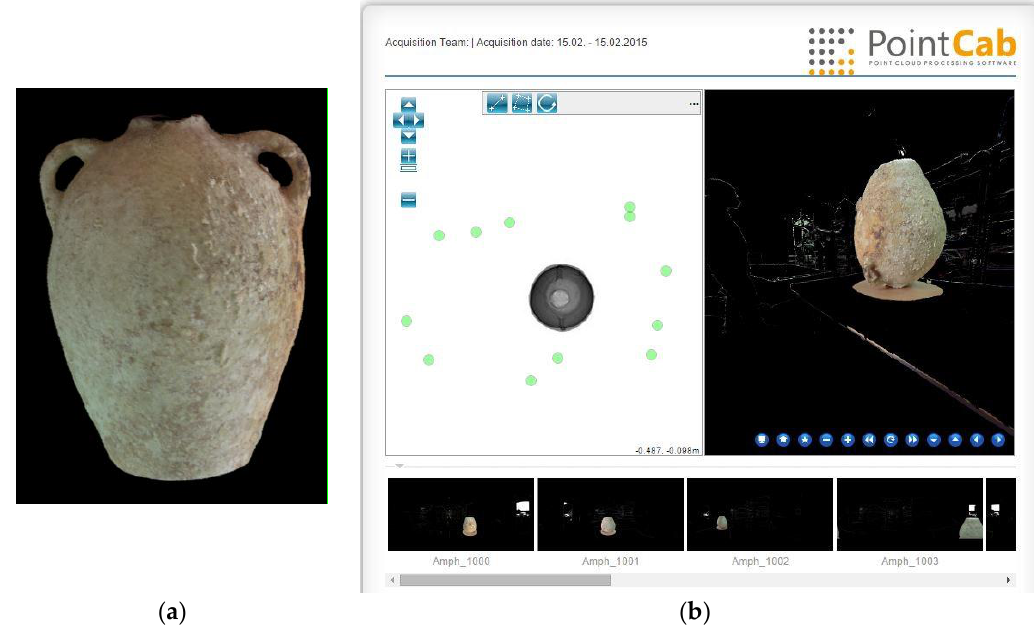
Figure 12. An exemplar output of a laser scanner of an amphora removed from wreck during a dig in July 2014; ( a ) a complete 3D model of an amphora; ( b ) the fusion of various captures of the laser scanner in order to obtain the complete 3D model (performed by DeMicoli & Associates with the University of Malta).